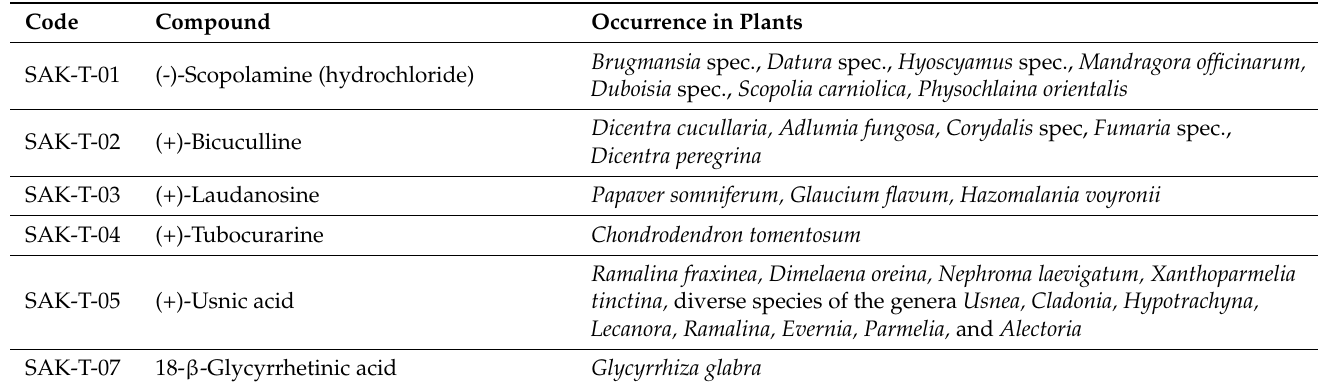
Table 1. Trivial names of 69 phytochemicals and the medicinal plants they are derived